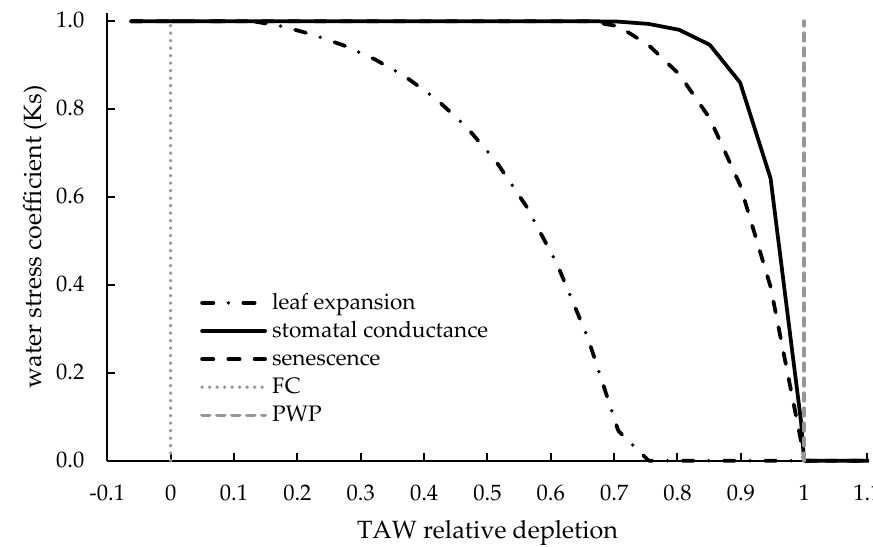
Figure 4. WS coefficients for vegetative growth and development in AQUACROP (redrawn from Steduto et al. [88]). The state variable used to calculate the coefficients is the total available water (TAW) relative depletion ratio. The example refers to maize water stress (WS) calculated at ET0 of 5 mm. The first stress threshold (leaf expansion affected) is met at 14% of TAW depletion. Transpiration and senescence processes begin to be affected both at 69% TAW depletion. Stress threshold for senescence is usually met at equal or higher depletion ratio than for transpirative stress, depending on the crop.